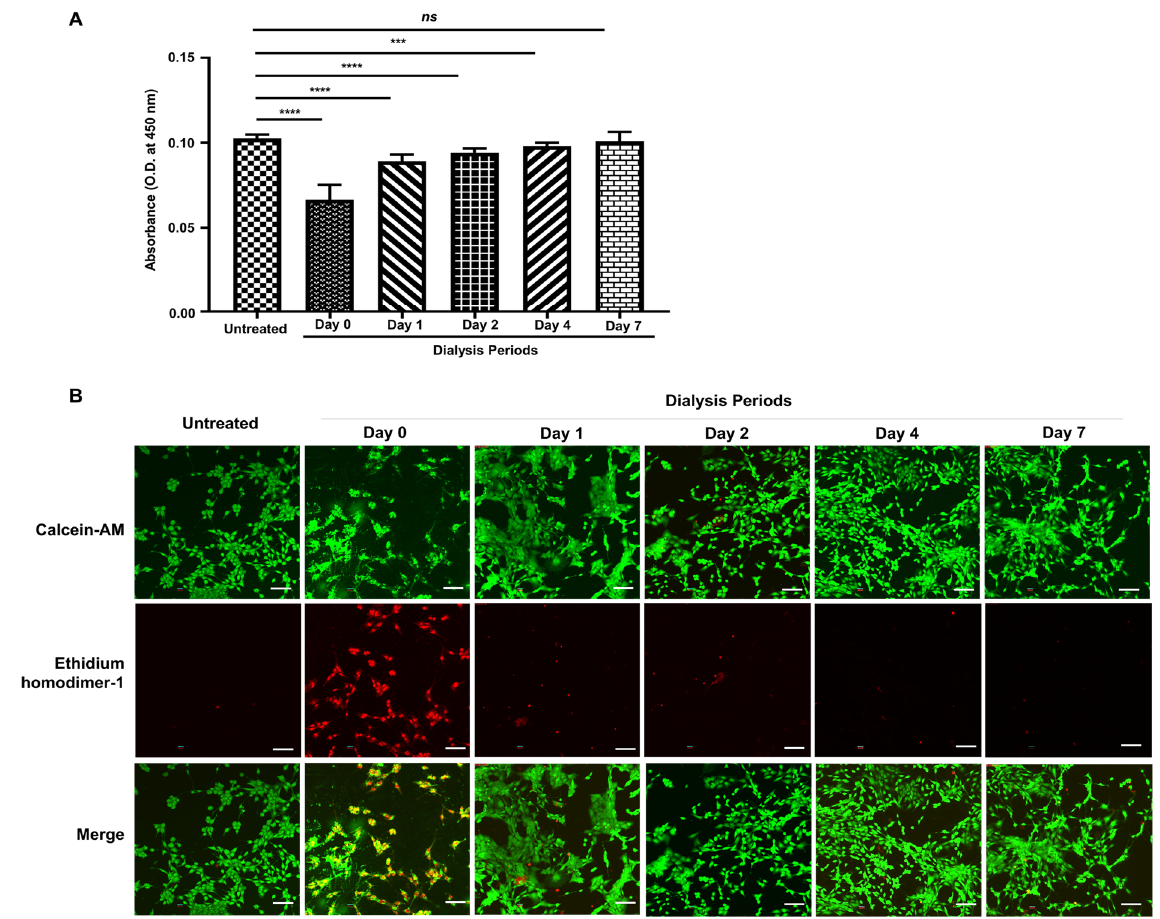
Figure 6. Cell proliferation and viability assay with NIH 3T3 on each dialysis period of modified silk fibroin with glycidyl methacrylate (Silk-GMA). ( A ). CCK 8 assay for cell proliferation rate gradually increased following dialysis period days 0, 1, 2, 4, and 7. **** p < 0.0001, *** p < 0.001, and ns = no significant. ( B ). NIH 3T3 cells were exposed with 0.1 g/mL of each dialyzed Silk-GMA sample for 72 h. NIH 3T3 cells were detected with Live & Dead assay with indication of calcein AM (live cells, green fluorescent protein) and ethidium homodimer-1 (dead cells, red fluorescent protein), separately. The confocal microscopic images showed that dead cells decreased, and then live cells proliferated gradually depending on dialysis periods (scale bar = 100 µm).